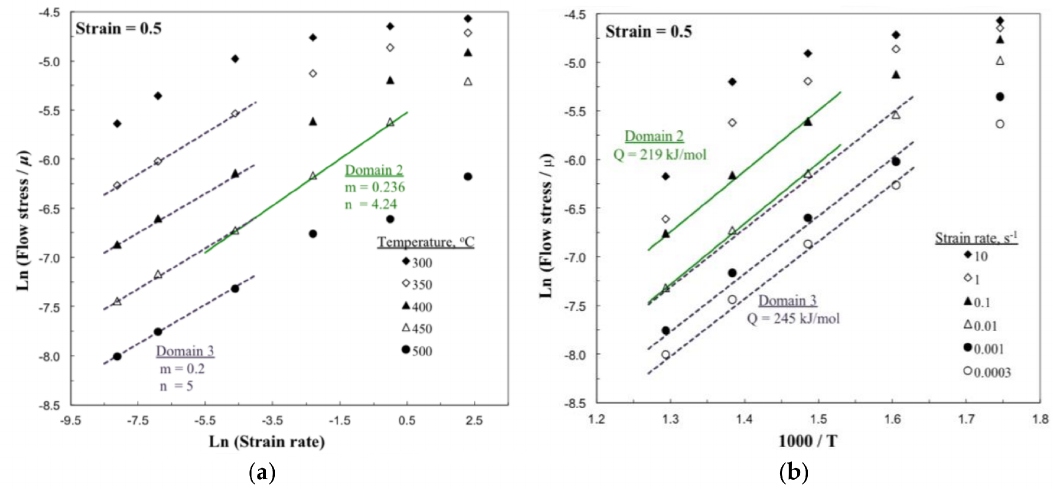
Figure 12. ( a ) Flow stress versus strain rate on the natural logarithm scale at various temperatures, and ( b ) normalized flow stress versus the inverse of absolute temperature at different strain rates for TXAZ3200